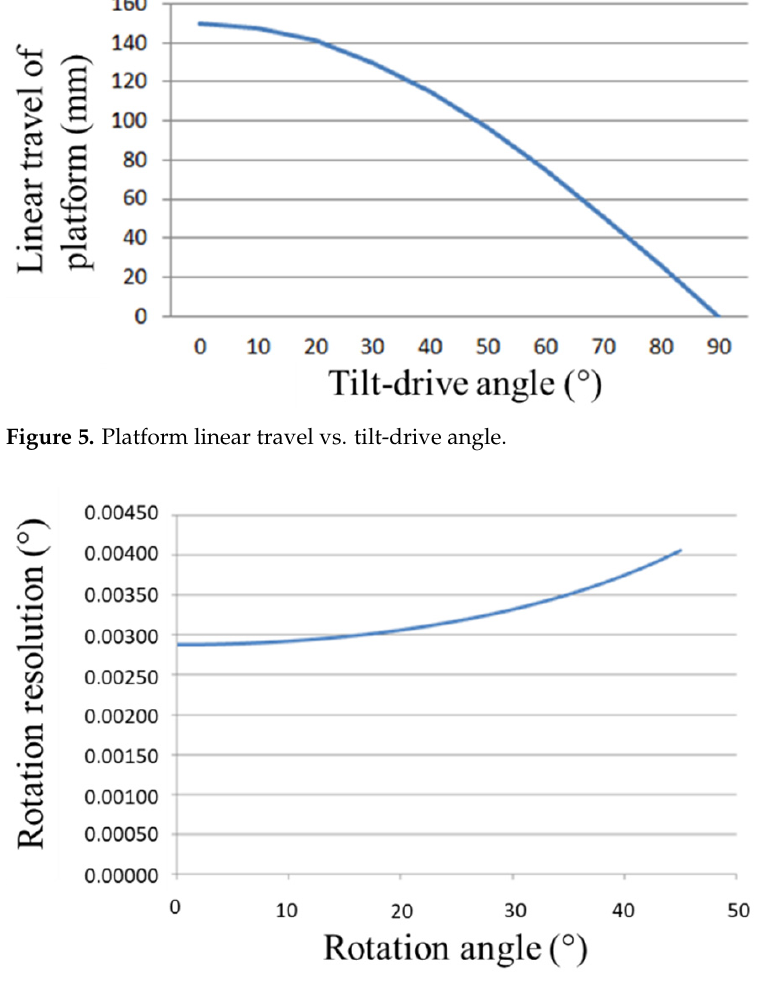
Figure 6. Rotation resolution of platform vs. rotation angle.